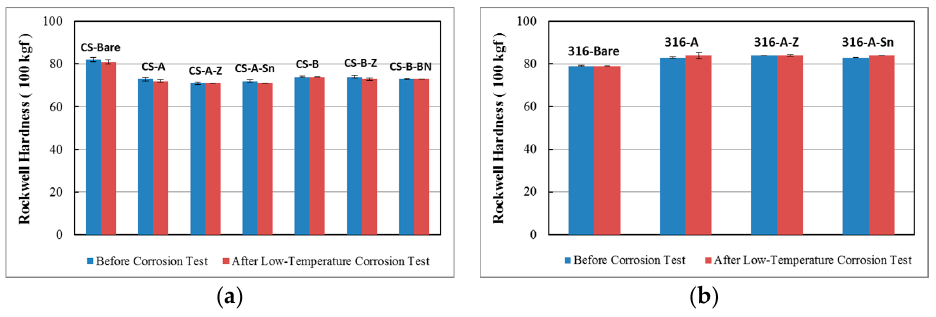
Figure 9. Comparison of Rockwell hardness of the original substrate before and after the low-temperature corrosive attack for ( a ) low carbon steel, and ( b ) 316 stainless steel substrates.